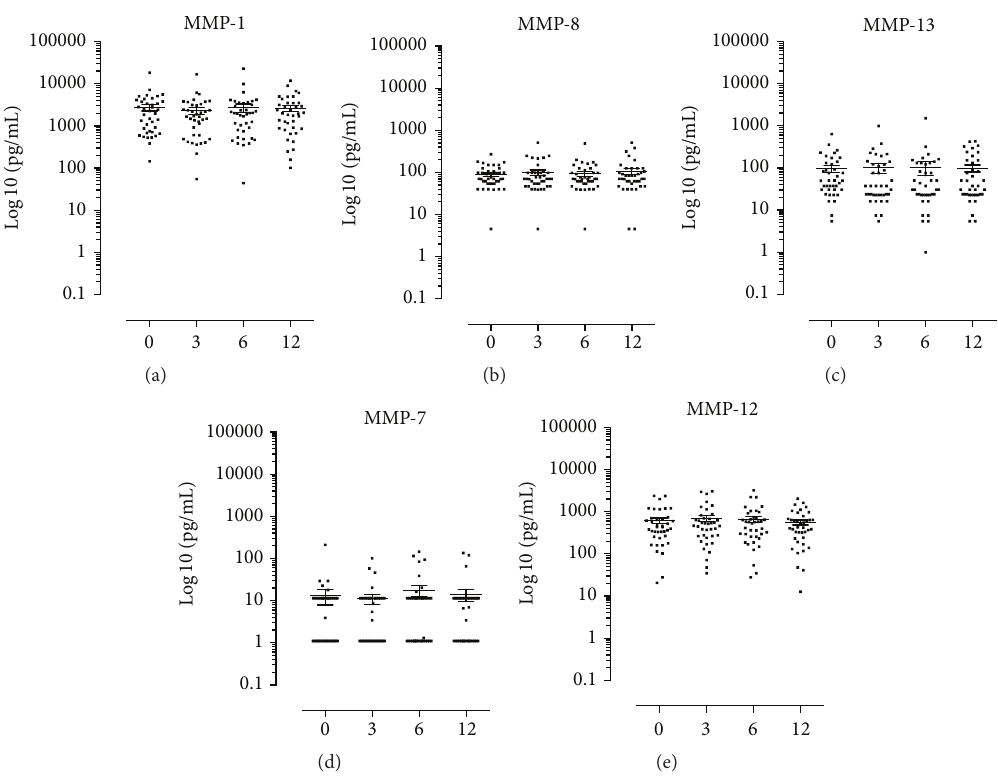
Figure 4: Matrix metalloprotease levels in serum from the RA patient cohort. (a) to (e) are scatter dot plots, where each dot represents one individual patient. The 𝑥 -axes illustrate the four assessment months after infliximab treatment is initiated. The 𝑦 -axes represent the concentrations in serum of their respective MMP in picograms per millilitre (pg/mL) on a log 10 scale. The horizontal lines in the dot plot illustrate the mean, and the vertical error lines represent ± standard error mean (SEM) in a paired 𝑡 -test.